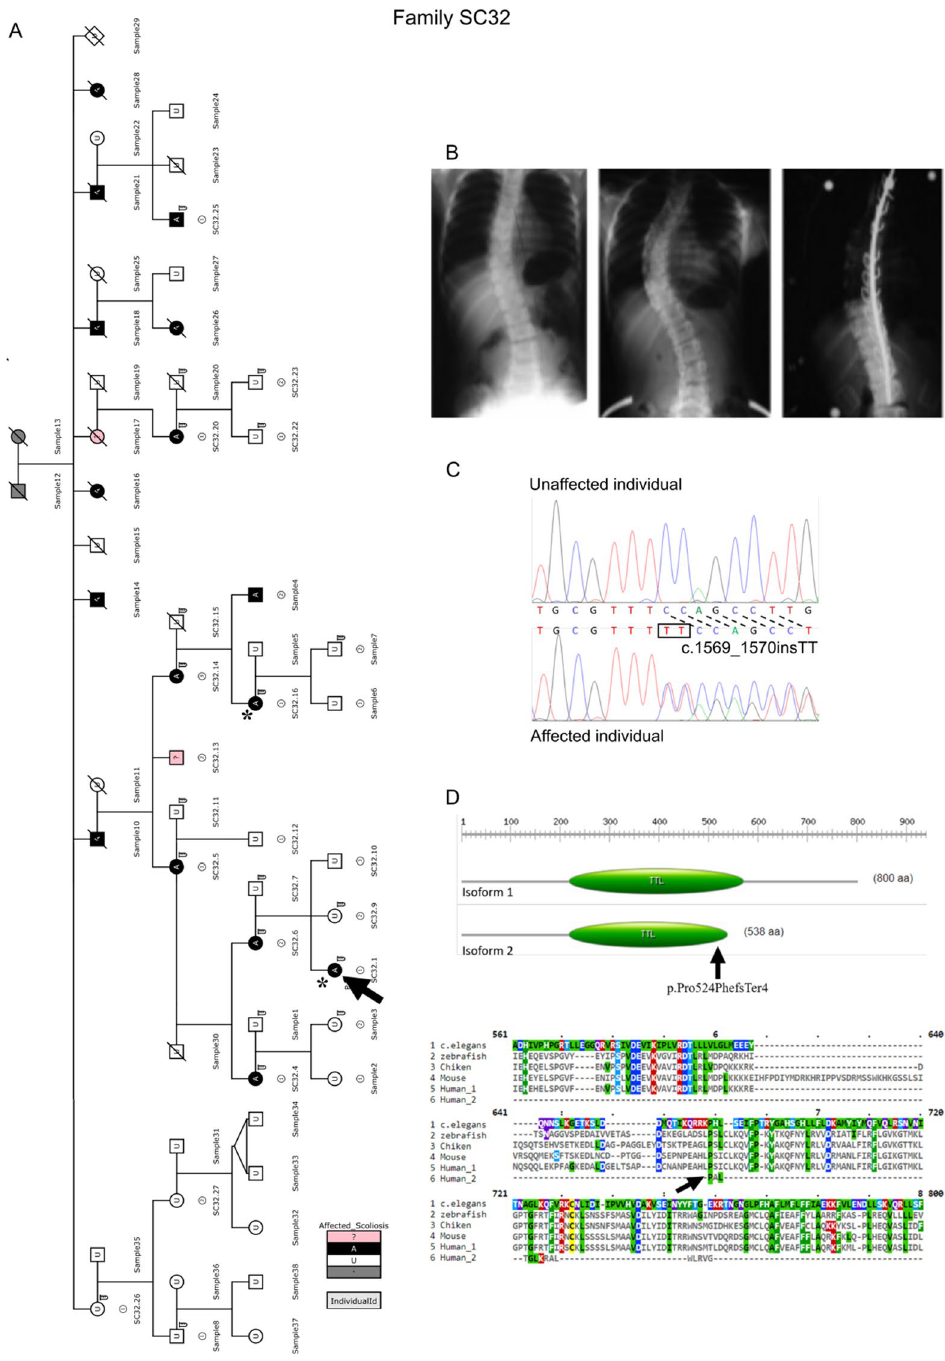
Figure 1. Pedigree of UK Family SC32 in which a putative gene mutation has been found. ( A ) Open circles and squares indicate unaffected individuals. Blackened circles and squares indicate affected females and males respectively. The arrow indicates family proband (SC32.1) and NGS sequenced patients are indicate by asterisks (SC32.1, SC32.16). ( B ) Standing posterior radiographs of proband V:3 of family SC32, showing right thoracolumbar spinal curvature in the absence of congenital vertebral abnormality. Cobb angle measurement of 40° at time of diagnosis (left panel), Cobb angle measurement of 56° before corrective surgery (middle panel), and spinal fusion (right panel). ( C ) Sequence obtained by Sanger sequencing of gDNA from scoliotic patient revealing the insertion of TT inducing a framshift (DE0193 lower chromatogram), compare to normal sequence of non-scoliotic patient (DE0194 upper chromatogram). ( D ) Representation of Human TTLL11 isoform 1 and 2 with the TTL domain showing the p.Pro524PhefsTer4 mutation (upper panel, black arrow), and partial alignment of TTLL11 by MUSCLE 96 from different species to identify conserved domains (lower panel, black arrow represents the mutated